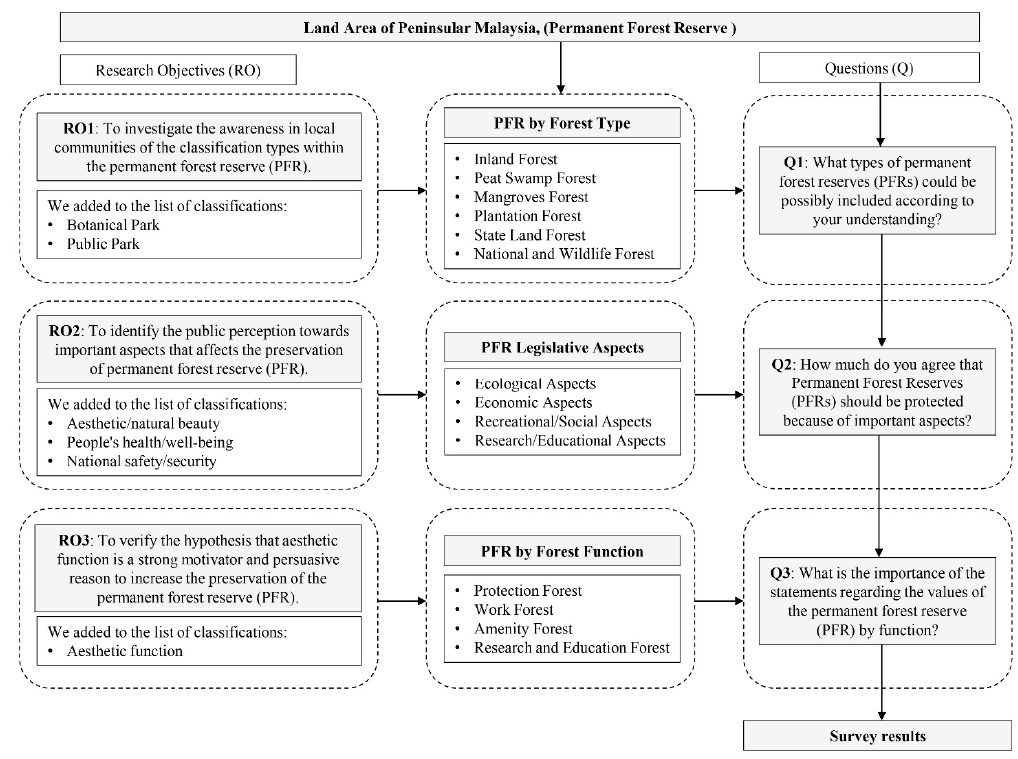
Figure 3. Formulation of survey questions based on the research objectives.